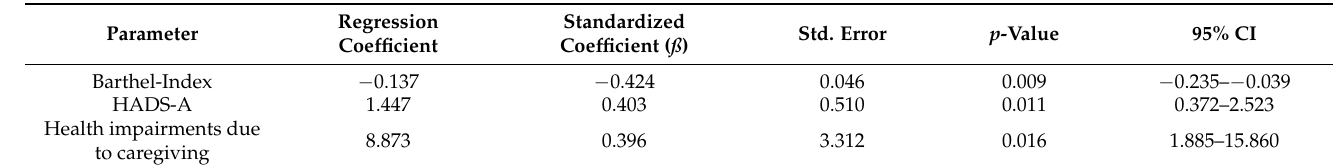
Table 4. Regression analyses of predictors of CGB: The ZBI score was the dependent variable in the multiple linear regression with backward stepwise selection. Abbreviations: HADS-A = Hospital Anxiety and Depression Scale–Anxiety Subscale, CI = confidence